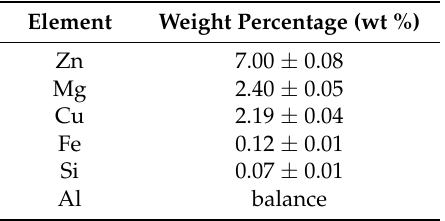
Table 1. The chemical composition of the investigated gas atomized Al7075